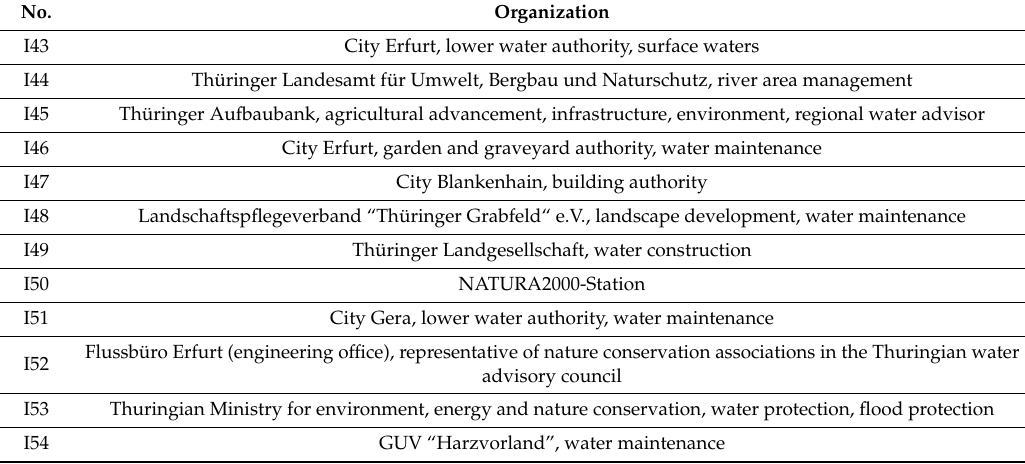
Table A5. Thuringia: January–March 2019.